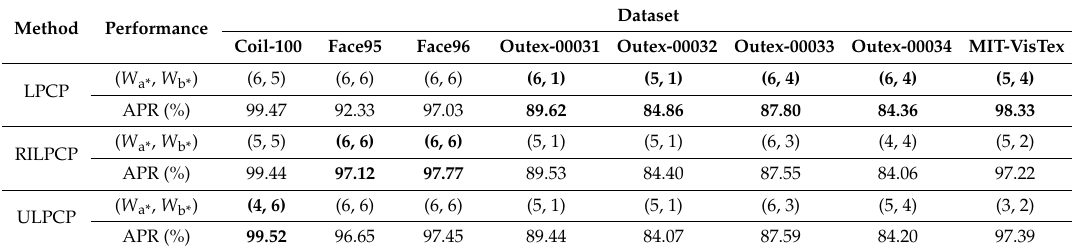
Table 2. The highest average precision rate (APR) values of LPCP, RILPCP, and uniform local parallel cross pattern (ULPCP) with the optimal color quantization layers ( W a* , W b* ) on the eight databases.